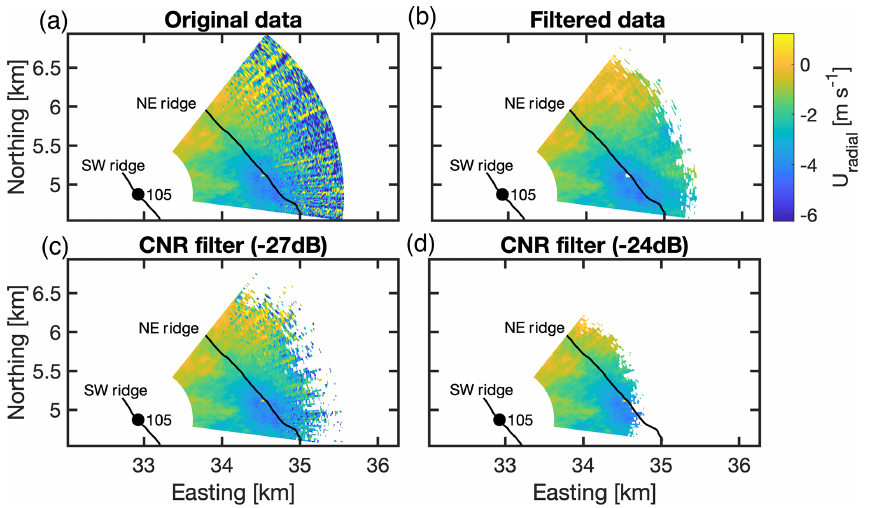
Figure 2. Comparison of data recovery with different filters for the 10min period starting on 3 May 2017 at 13:40UTC. (a) Unfiltered data, (b) filtered data following the approach described in Sect. 4.2.1, (c) − 27dB filter, and (d) − 24dB filter. Table 2. Operation time and data availability of SLs. The number in brackets is the number of available 10min periods. Scanning